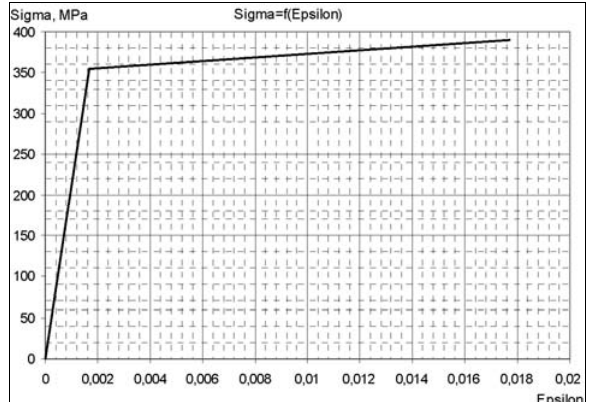
Fig. 3. Bi-linear stress-strain curve of material Fig. 4 illustrates the finite element model, where the flanges and the web of a steel beam are discretised with three-noded shell elements.